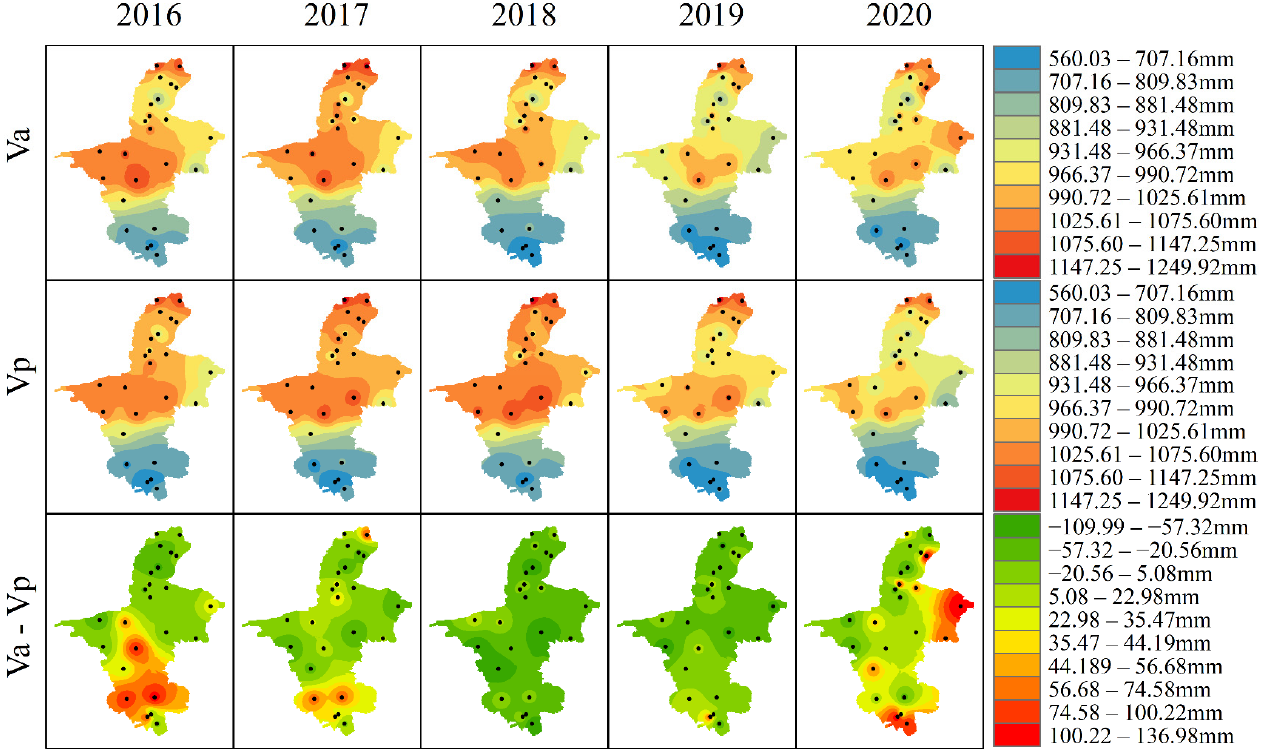
Figure 7. Distribution of and differences between actual and predicted values, unit/mm (Va is the actual value from 2016 to 2020, Vp is the predicted value from 2016 to 2020, and Va-Vp is the actual value minus the predicted value).